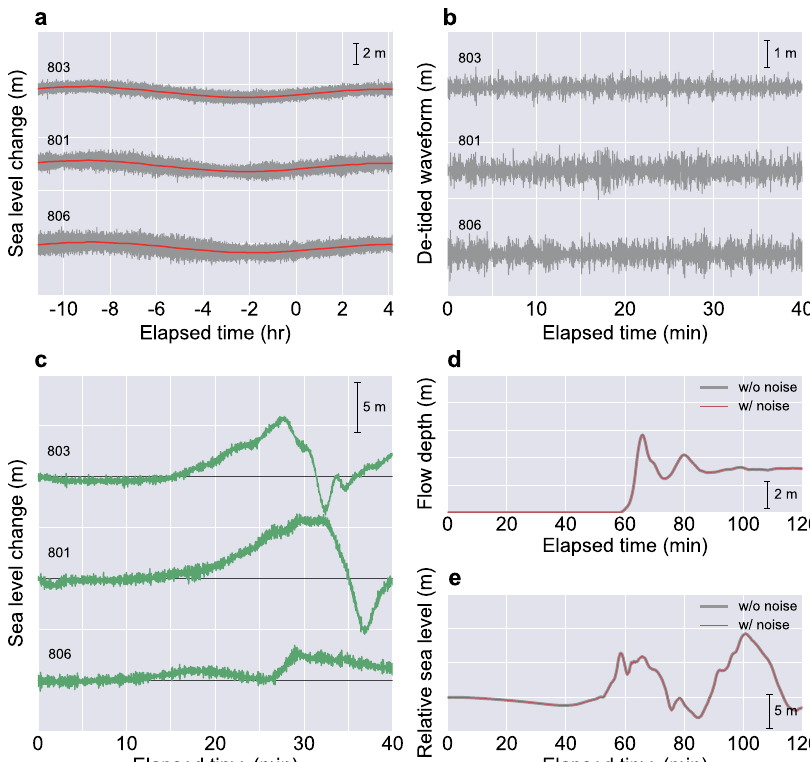
Fig. 7 Noise waveforms and convolutional neural network (CNN) tsunami forecasting results with and without noise. a Sea-level observations from GPS buoys before the 2011 tsunami event. The grey and red lines represent the raw observations and the 15 min running average of the raw data, respectively. The elapsed time is from a day before the earthquake occurrence. b Noise waveforms extracted from the observations. The deviation from the averaged data (the red lines in a ) is extracted as noise. The fi gure shows the noise waveforms during the same observation period for the actual tsunami observations, but a day before the tsunami. c Noise waveforms for CNN input. The extracted noise waveforms before the event are added to the actual tsunami observations to prepare the noise inputs. d Inundation forecasting results with and without noise. The grey and red lines represent the forecasting results without and with noise, respectively. Because the difference between the two waveforms is small, the result without noise is illustrated with a thicker line. e Offshore tsunami forecasting results with and without noise. The grey and red lines represent the forecasting results without and with noise, respectively. Because the difference between the two waveforms is small, the result without noise is illustrated with a thicker